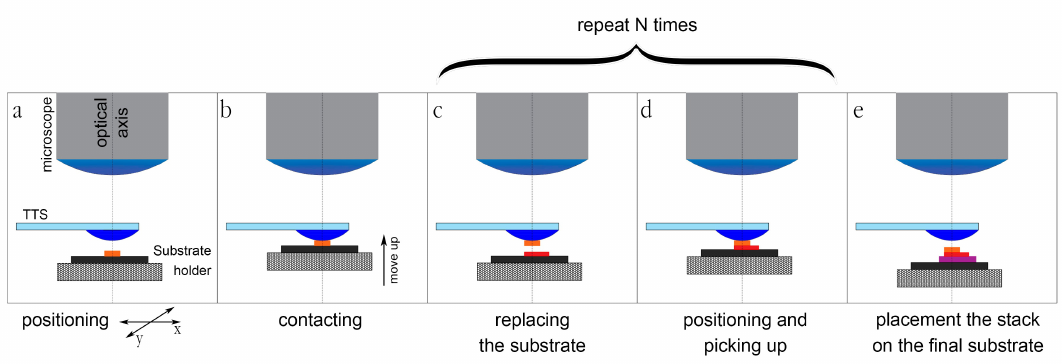
Figure 1. Stages of the dry pick-up transfer process for VdW heterostructure